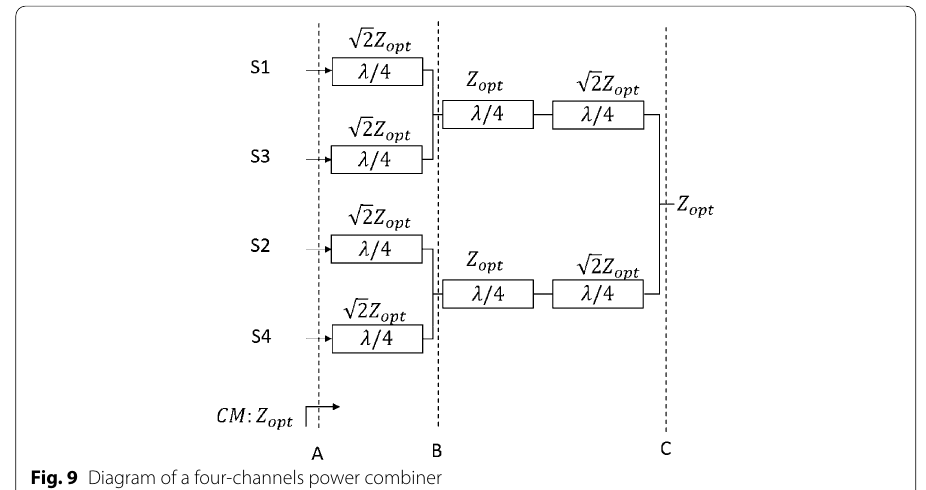
Fig. 9 Diagram of a four-channels power